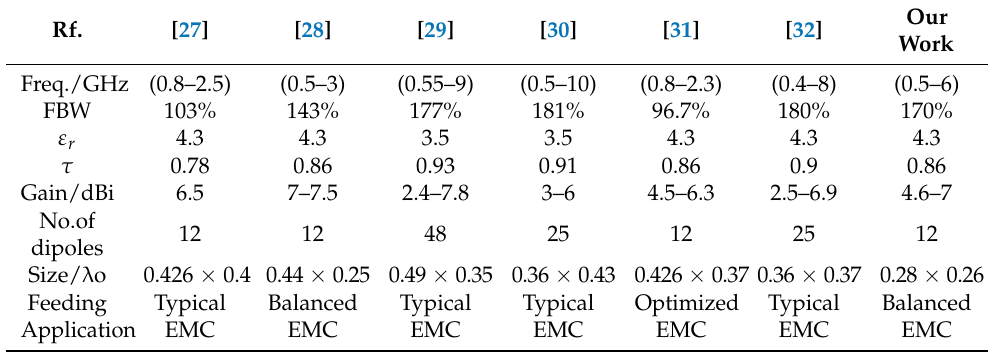
Table 3. A comprehensive comparison between the proposed design and the literature papers. Rf.